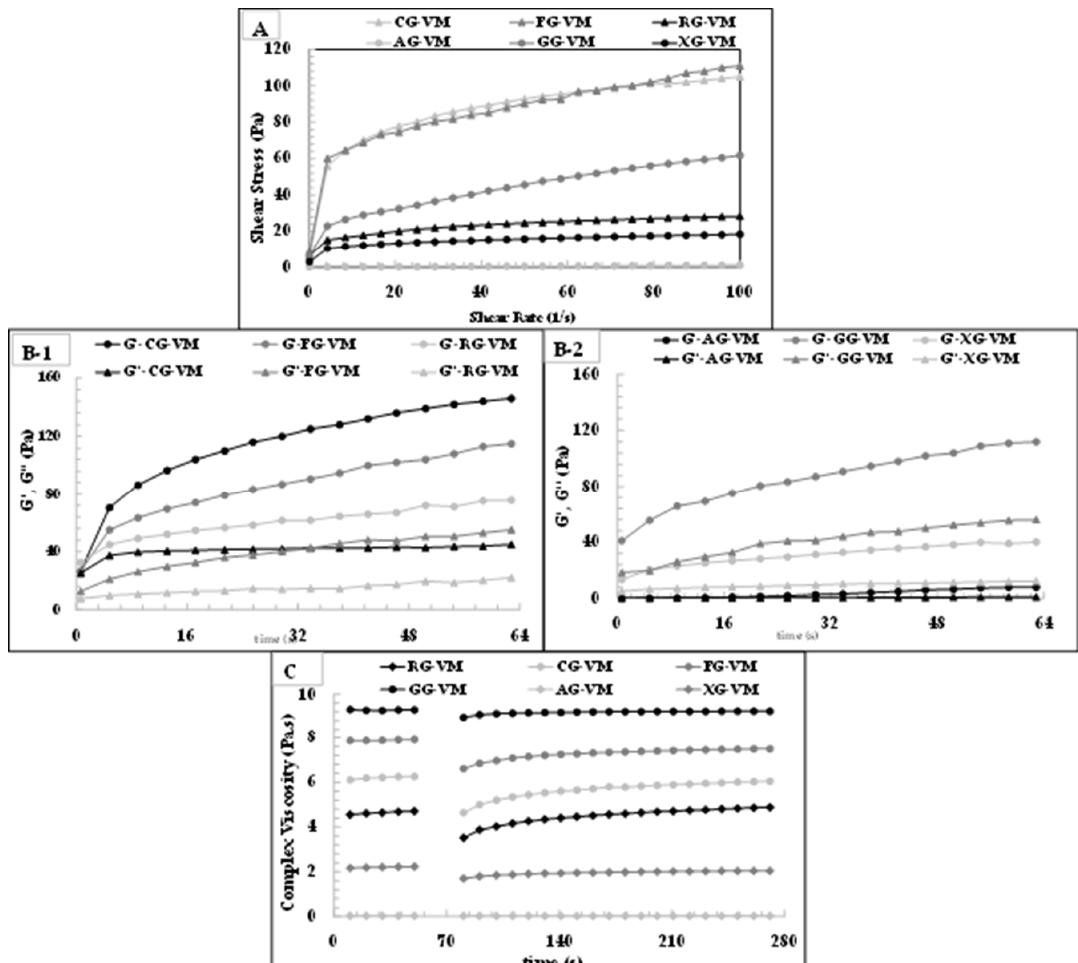
Figure 7. Rheological properties of vegan mayonnaise samples formulated with different gums. FG-VM: flaxseed oil byproduct gum vegan mayonnaise, CG-VM: chia seed oil byproduct gum vegan mayonnaise, RG-VM: rocket seed oil by-product gum vegan mayonnaise, GG-VM: guar gum vegan mayonnaise, XG-VM: xanthan gum vegan mayonnaise, AG-VM: gum Arabic vegan mayonnaise. ( A )